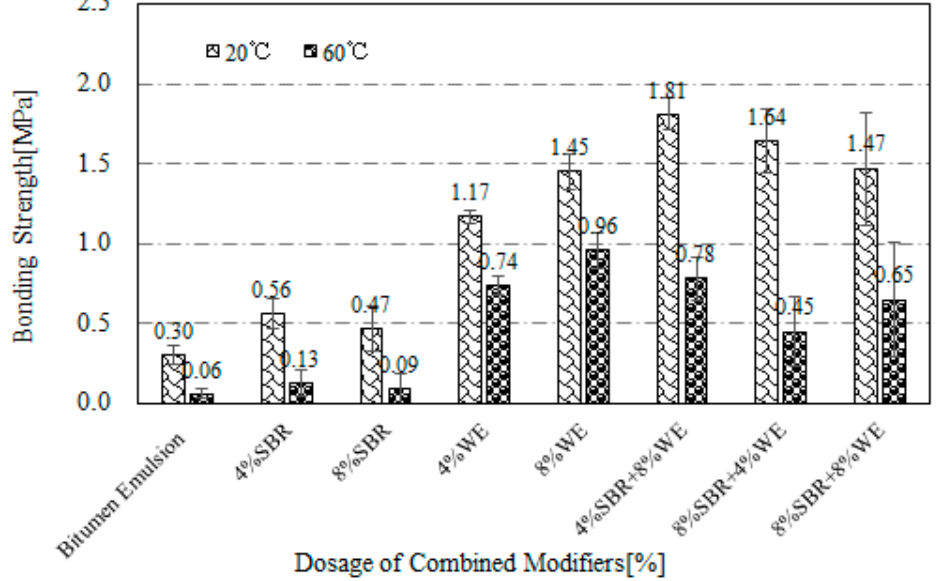
Figure 4. Bonding strength of Styrene butadiene rubber latex (SBR) and waterborne epoxy adhesive (WE)-modified bitumen emulsion.